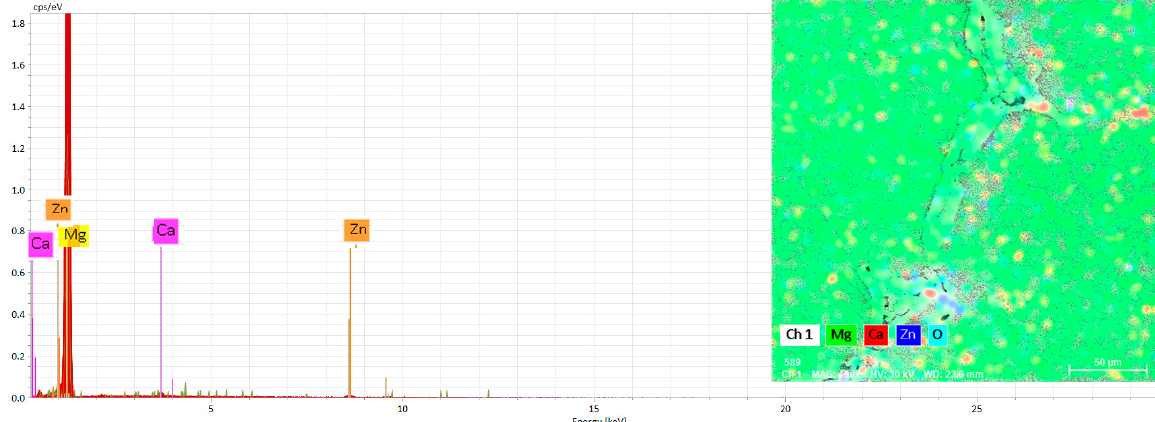
Figure 3. EDS spectra of the Mg–Ca–Zn alloys.